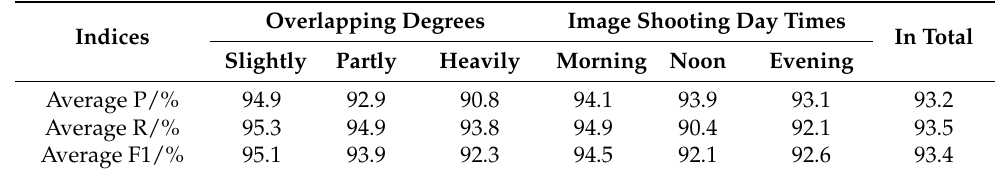
Table 2. Average statistics for 100 images under different overlapping conditions and at different times of the day.